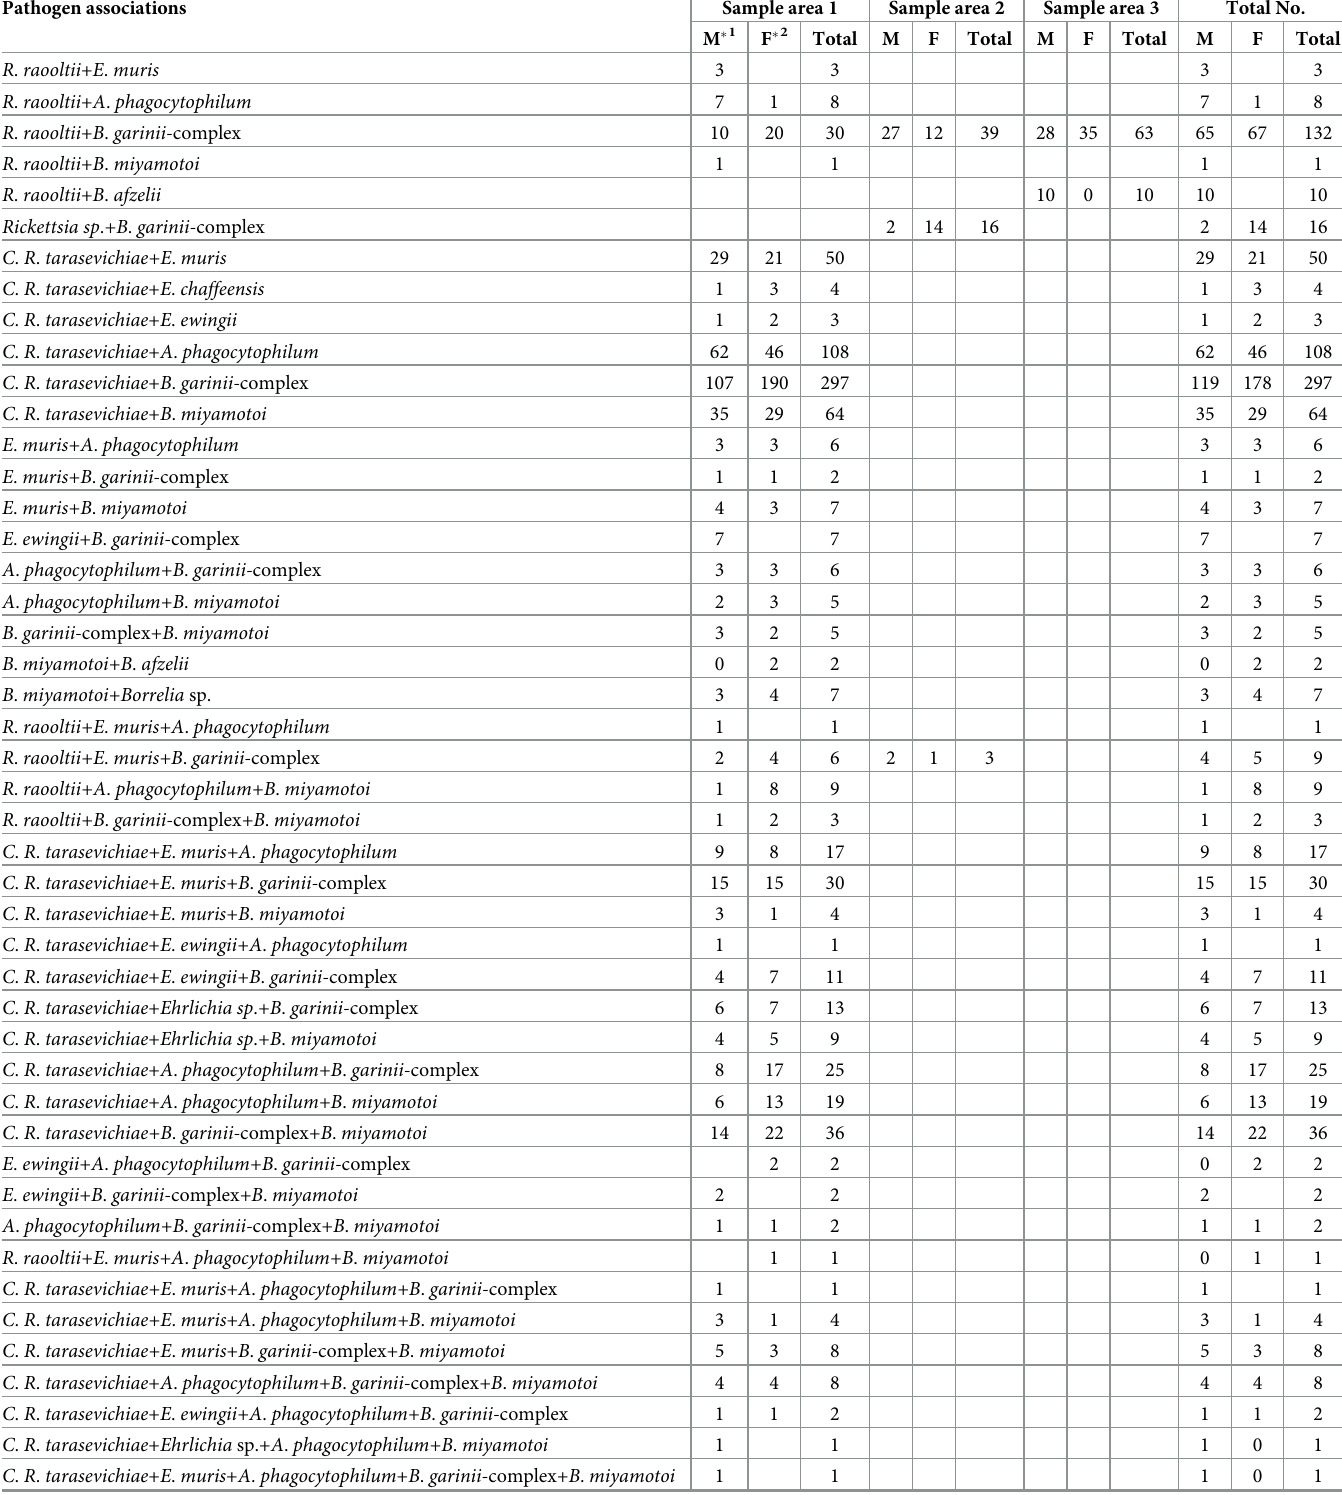
Table 4. Pathogen co-infection type in Tick